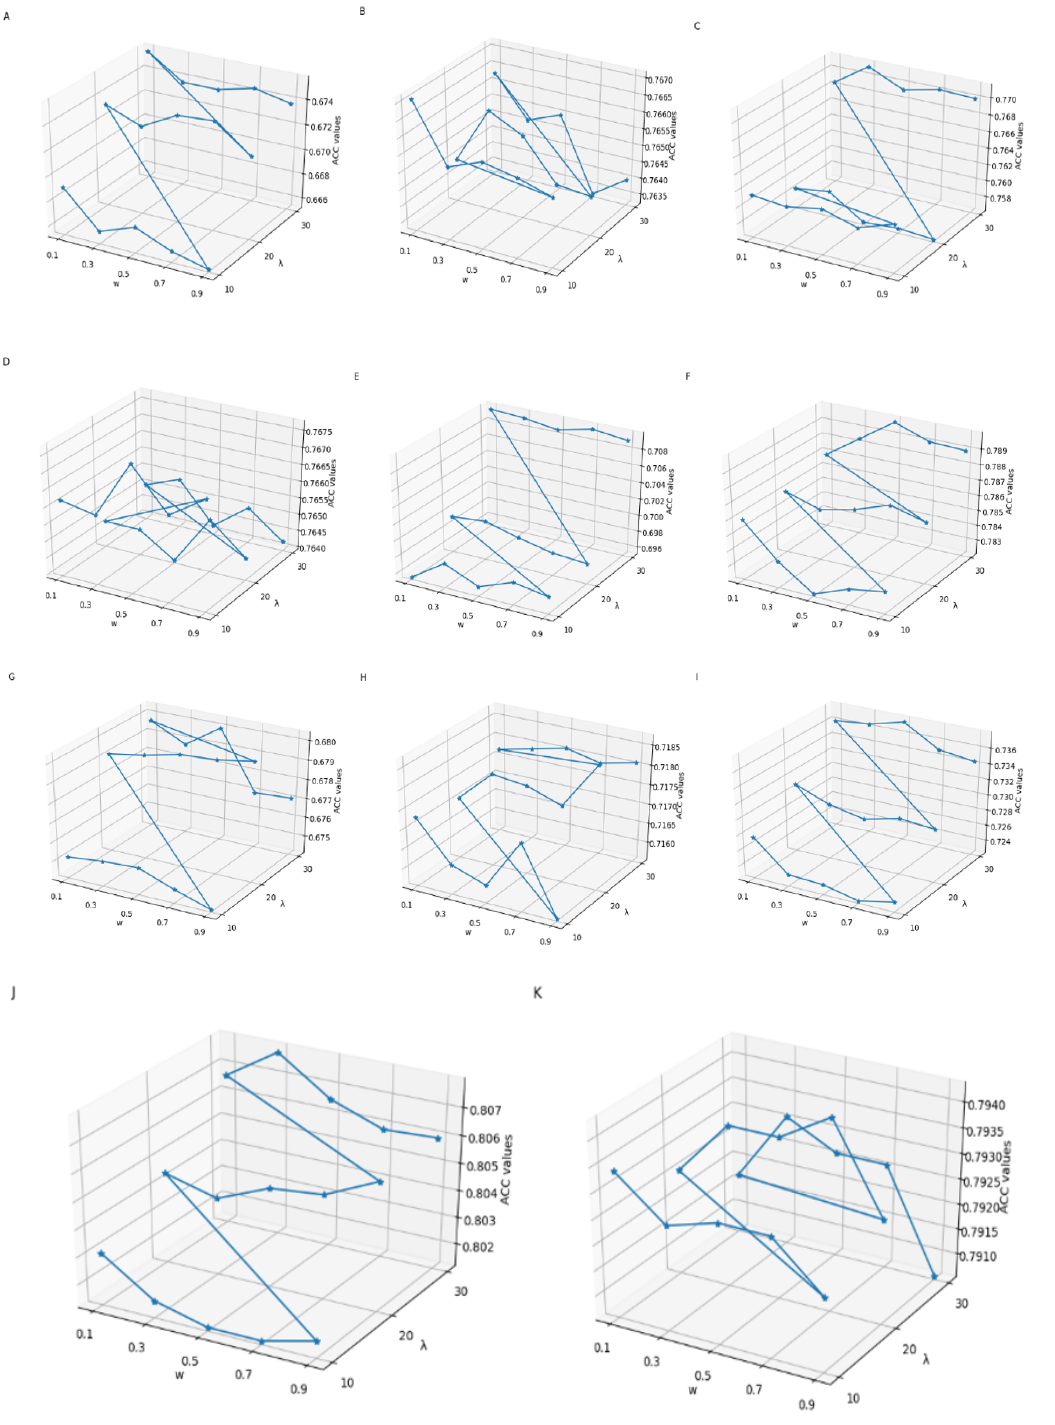
Figure 2. The effect of choosing different λ and w values in PseDNC on eleven datasets ( A ) H_B, ( B ) H_K, ( C ) H_L, ( D